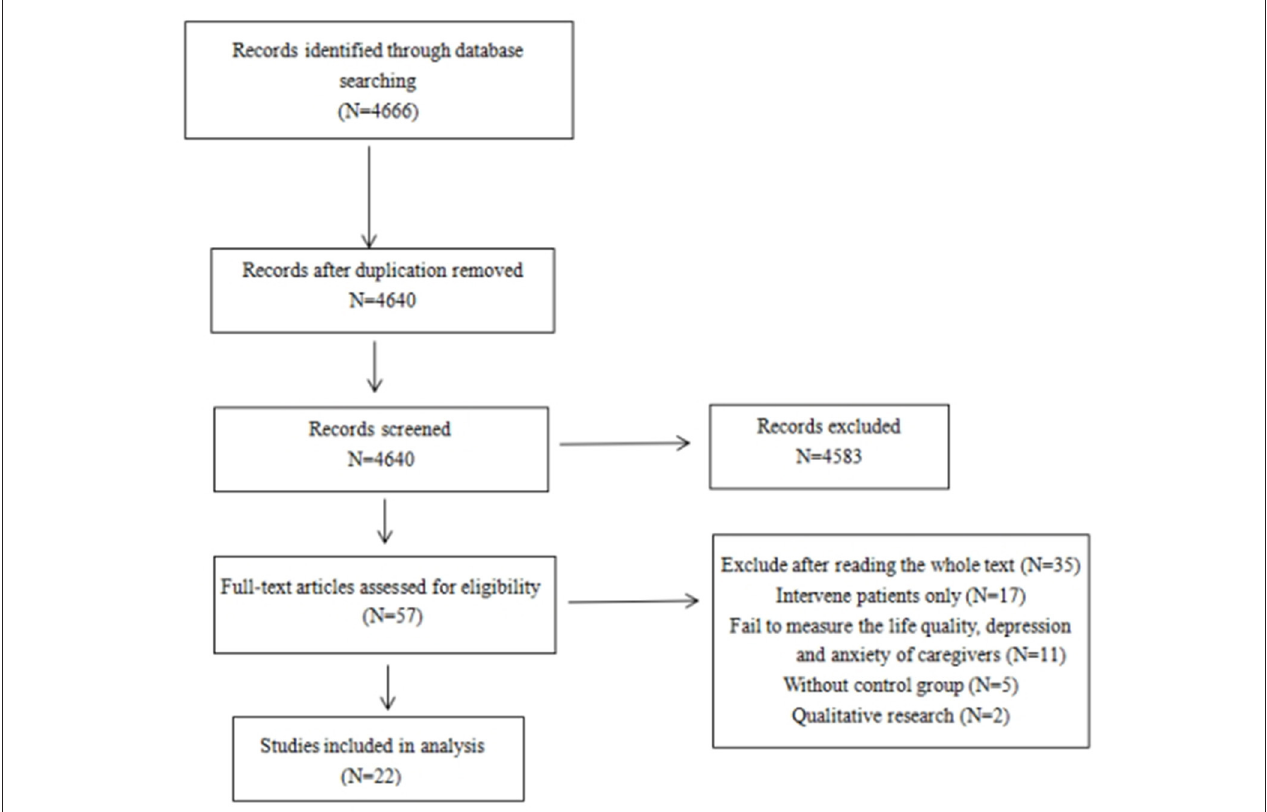
FIGURE 1 | Final process of inclusion and exclusion of studies for literature